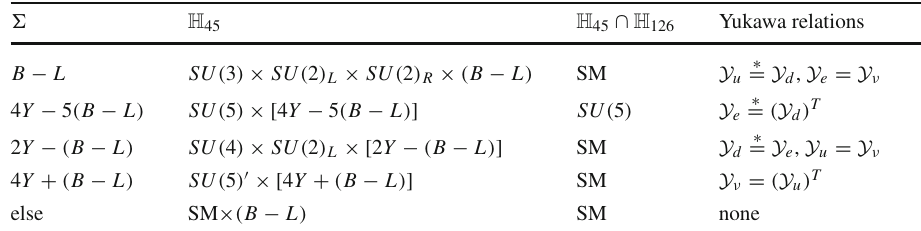
Table 4 Breaking patterns of 45 + 126 + 126 . Note that the 126 VEV always leaves SU ( 5 ) unbroken, i.e. H 126 = SU ( 5 )